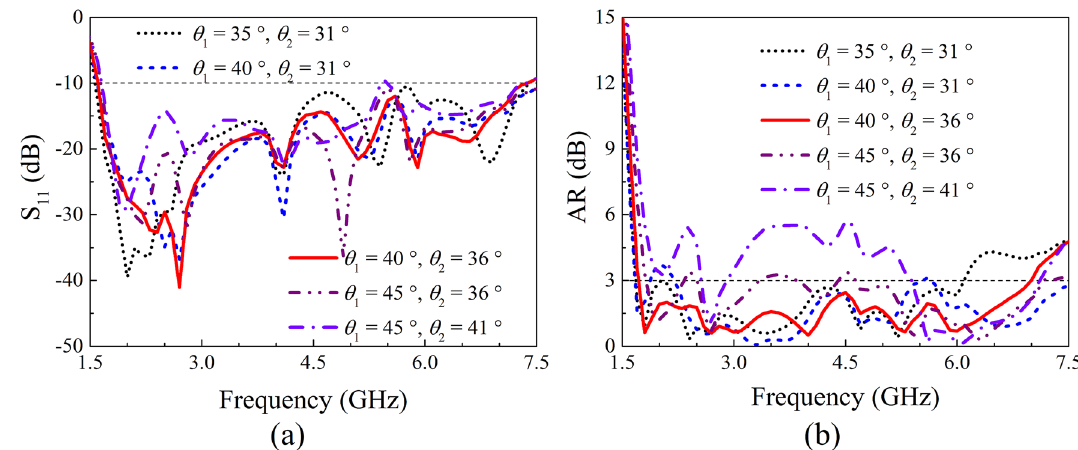
Figure 6. Effect of different θ 1 and θ 2 on S 11 and AR, respectively. ( a ) S 11 , ( b ) AR.